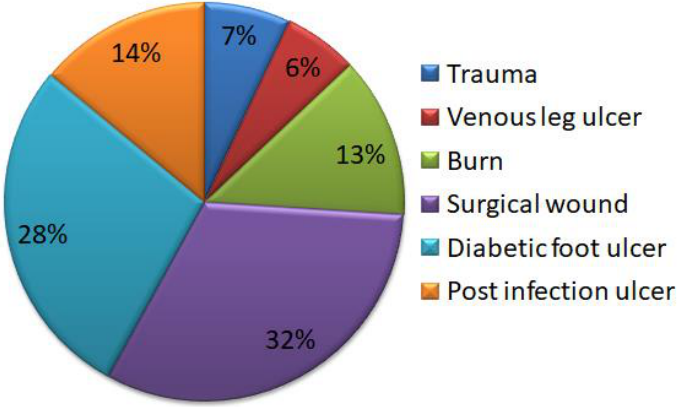
Figure 1. Pie chart representation on percentage of wound resources.